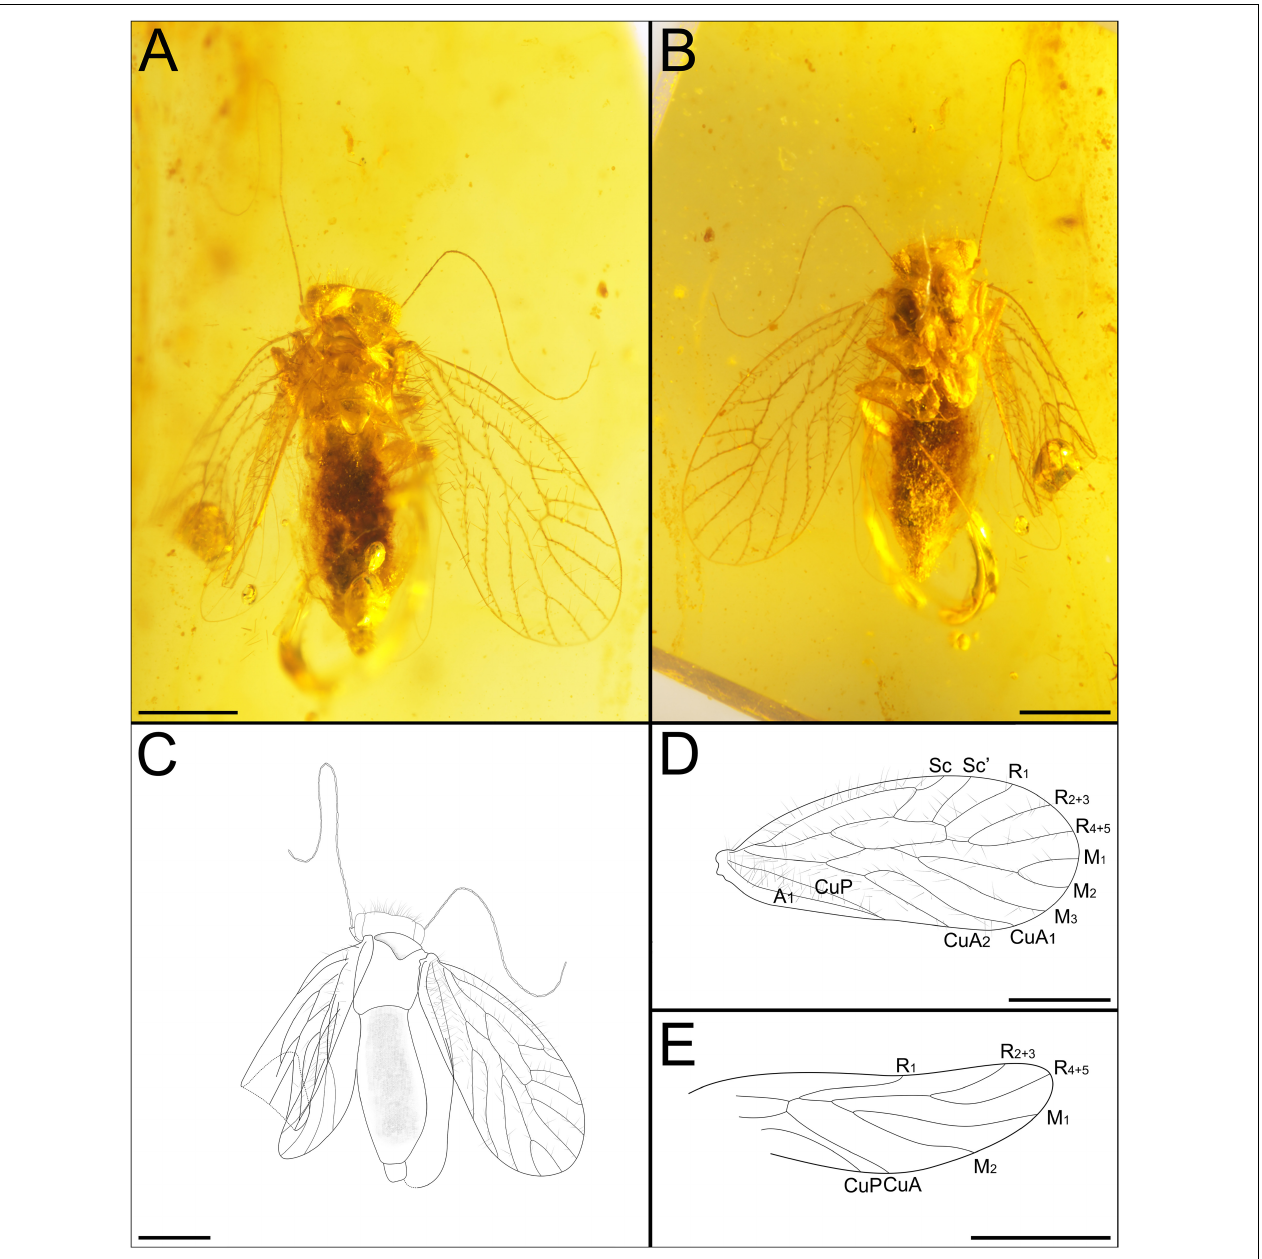
FIGURE 4 | Habitus of Burmempheria curvatavena Li, Yoshizawa and Yao, sp. nov. CNU-PSO-2015003. (A) Photograph in dorsal view; (B) photograph in ventral view; (C) line drawing in dorsal view; (D) line drawing of forewing; (E) line drawing of hind wing. Scale bars:0.5